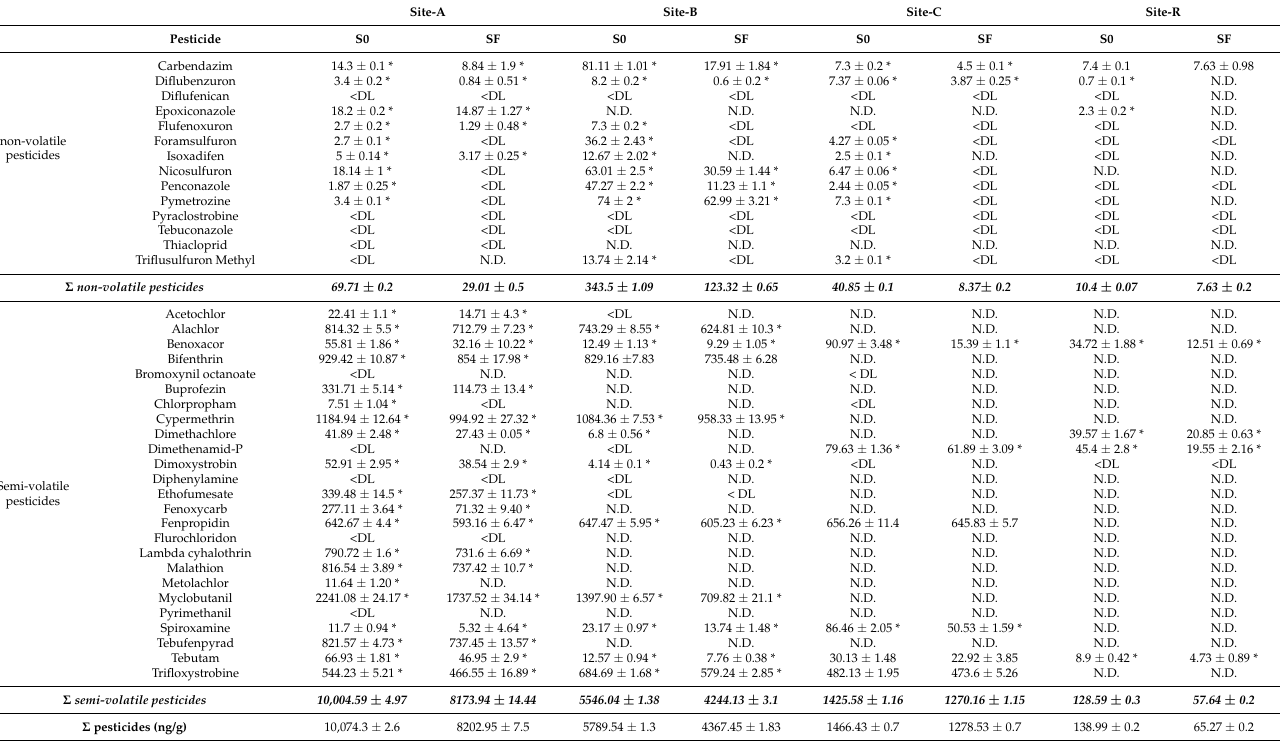
Table 1. Concentration of pesticides (ng/g) in soils collected from the three sites of the orchard at the beginning (S0) and the end (SF) of the sampling campaign (Site-A: center of the orchard, Site-B: border of the orchard, Site-C: control site outside the orchard, Site-R: reference site). The data are presented as mean ± RSD (n = 3 for each site).